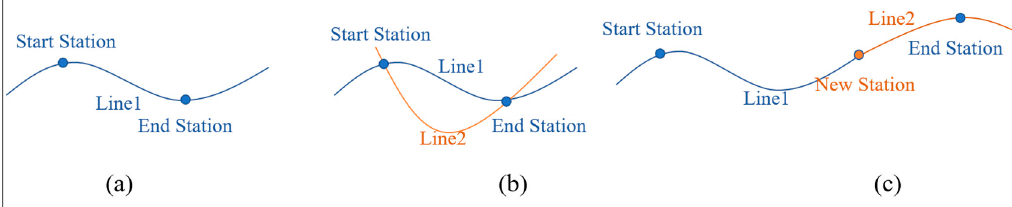
Figure 3. Line information of the station. ( a ) Only one line connecting the station node pair. ( b ) Two lines connecting the station node pair. ( c ) No corresponding line passing between the station node pair.